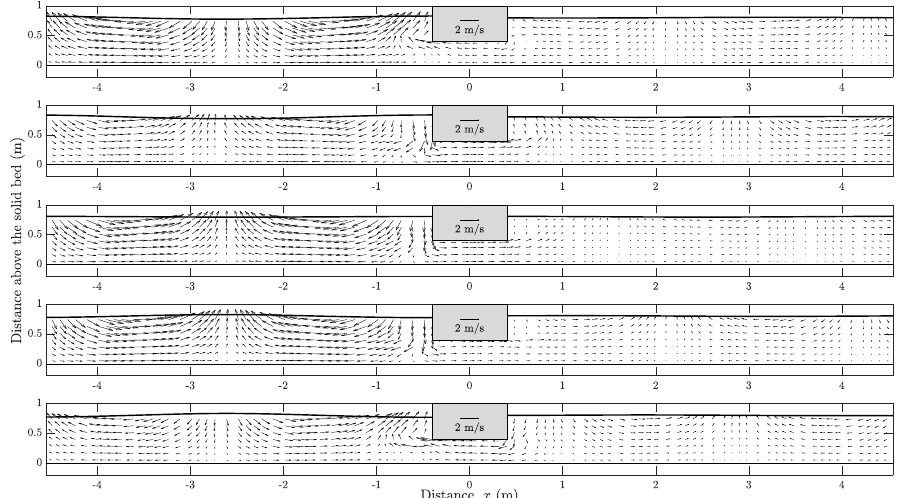
Figure 10. Surface obstacle on a solid bed ( d m = 0 ) : snapshots of velocity field at six time instants over a wave period. Top to bottom: t / T = 1 arrow inside the obstacle shows the reference magnitude. See Figure 8 for the model